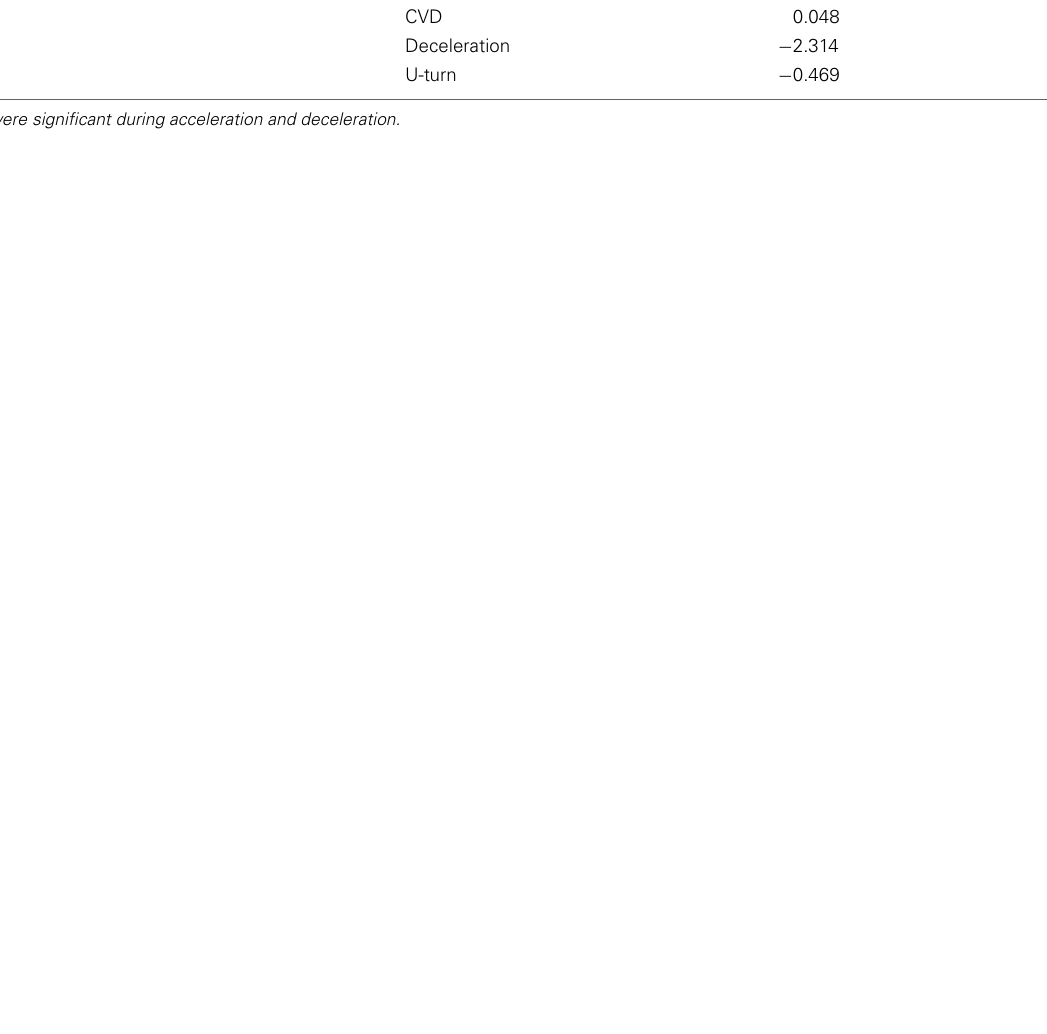
Table A4 | (cid:2) COE in the left and right FEF. INDEPENDENT t -TEST Right BA8-Left BA8